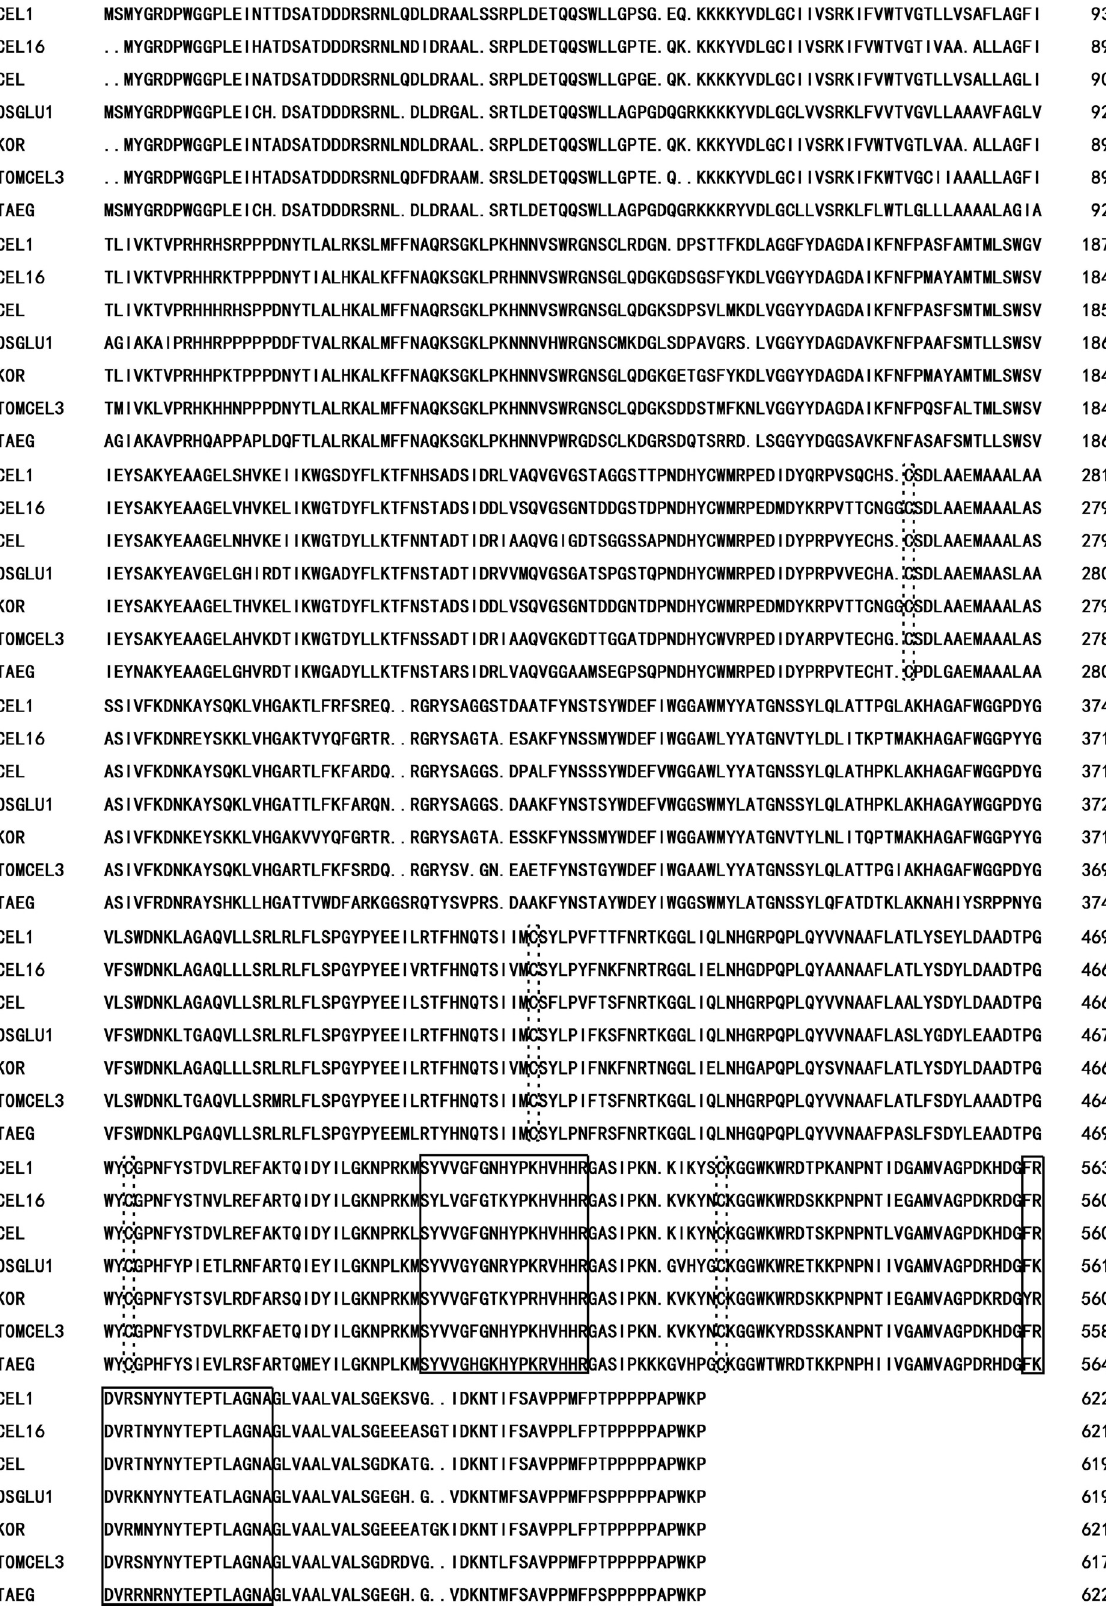
Figure 3 - Alignment of the deduced amino acid sequence of TaEG with other plant EGase sequences. Four Cys residues and two putative glycosyl hydrolase active sites are indicated by the dotted line and solid line frames,